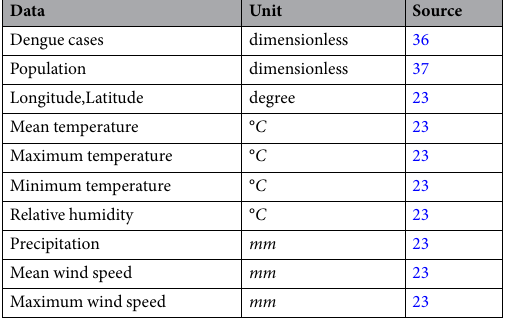
Table 6. Sources of the